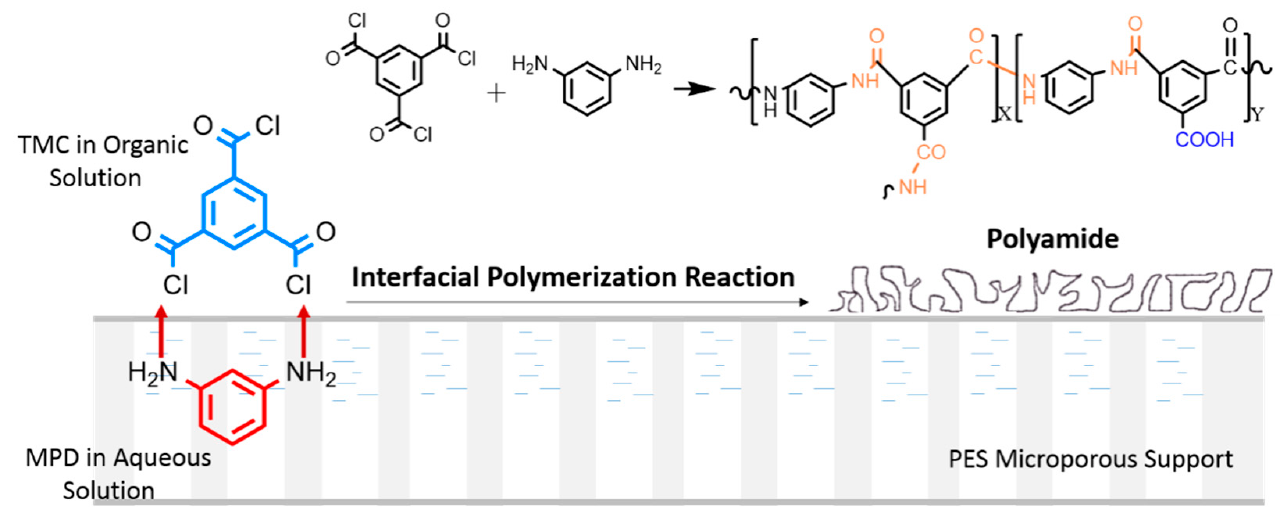
Figure 1. Schematic representation of the interfacial polymerization reaction between MPD and TMC at the surface of PES substrate.